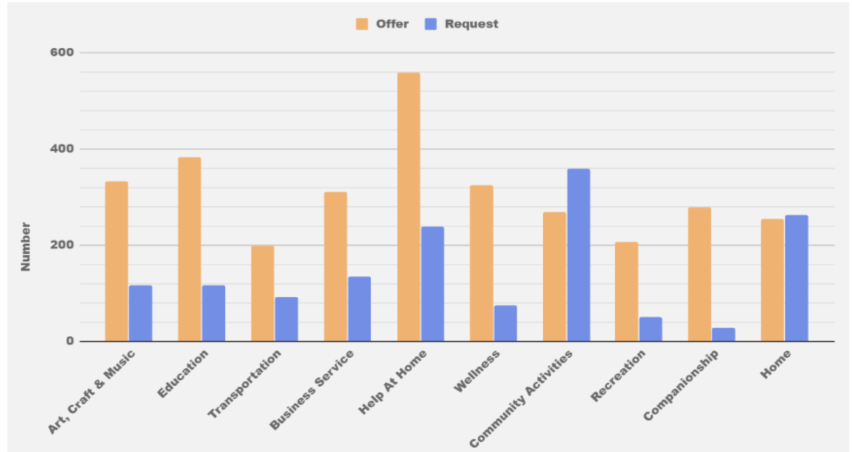
Figure 5. Relative service ratios of supply-versus-demand measured in TimeBank